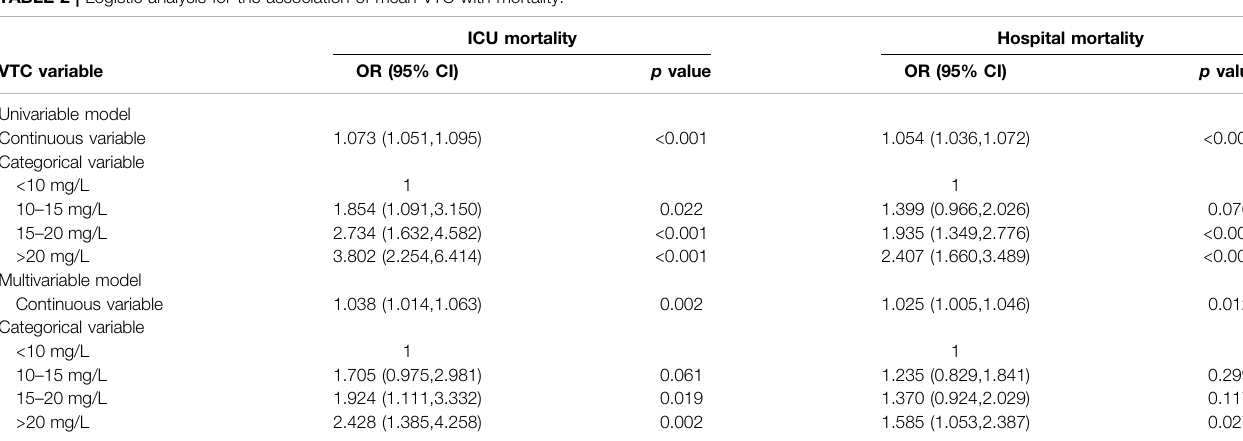
TABLE 2 | Logistic analysis for the association of mean VTC with